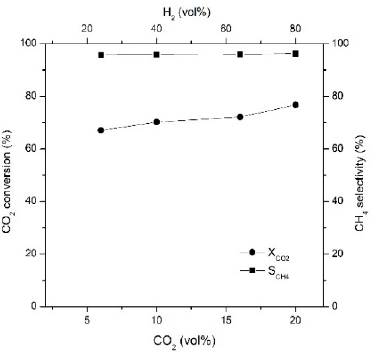
Figure 4. Effect of CO 2 concentration on CO 2 conversion and CH 4 selectivity.